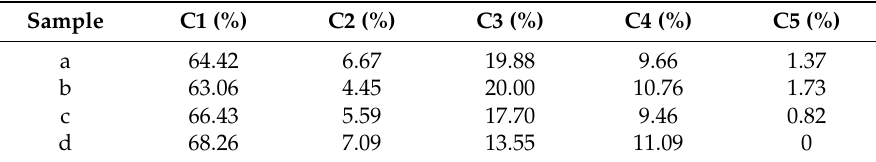
Table 2. Relative amounts (%) of carbon (C 1s) on the surfaces of films a–d.